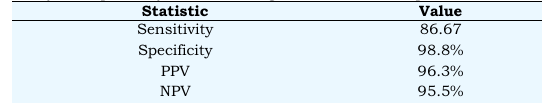
Table 5 Sensitivity and specificity of culture diagnostic method compared to ITS